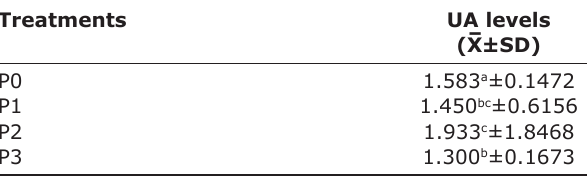
Table-4: Average values and SD of the serum UA levels in white rat ( R. norvegicus ) after treatments.